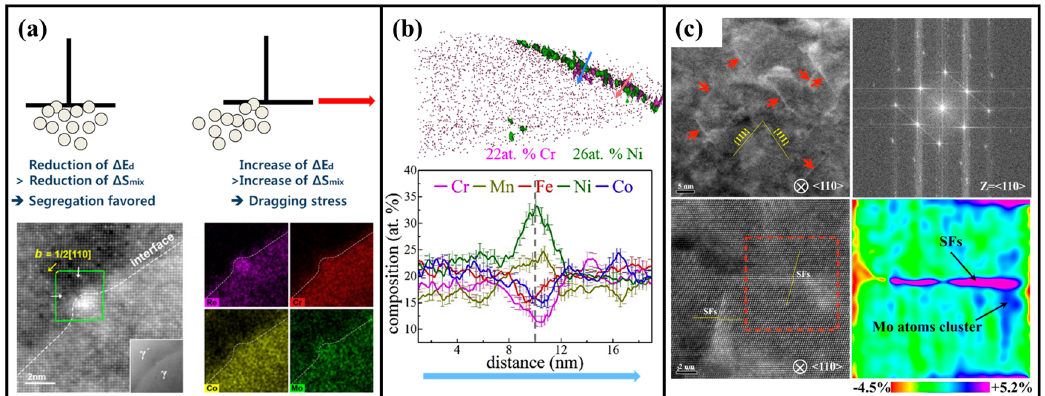
Figure 8. Solute segregation for different structures. ( a ) Hypothetical representations of interaction of atoms with a dislocation and STEM and chemical analysis of interfacial dislocation core structure at the atomic scale. The green square indicates the position of dislocation core. The lower right corner shows the EDS maps showing distribution of elements Re, Cr, Co, and Mo at the dislocation core are (Reprinted with permission from Ref. [87]. Copyright 2018, Elsevier; Reprinted with permission from Ref. [89], Copyright 2018, Taylor & Francis). ( b ) Segregation at grain boundaries along the blue arrow (Reprinted with permission from Ref. [110]. Copyright 2019, Elsevier). ( c ) HAADF − STEM image of Cr20Fe6Co34Ni34Mo6 alloy showing the segregation of Mo to stacking faults. The red arrows represent the stacking faults. The lower right corner shows the elemental distribution in the red square (Reprinted with permission from Ref. [130].Copyright 2019, Taylor &